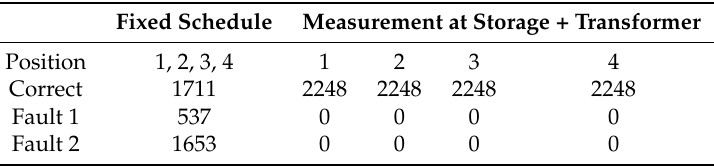
Table 9. Results for the scenario with measurements at the storage and